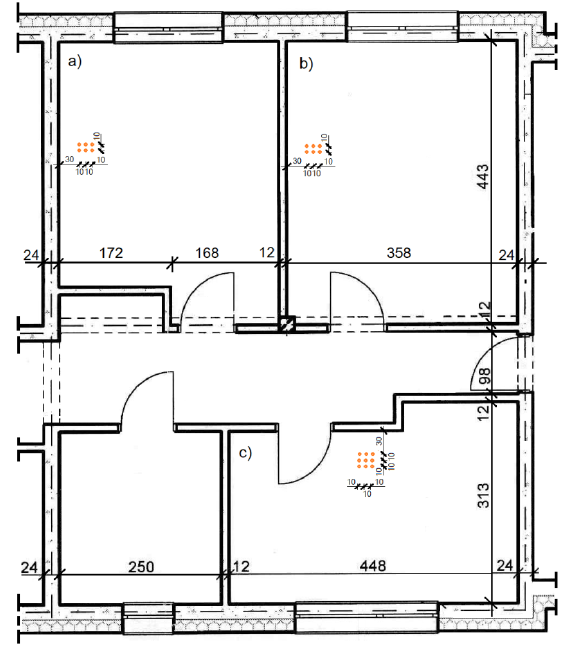
Figure 3: Sketch of the placement of measurement benchmarks (dimensions in centimetres): a) room R-PF, b) room R-G, c) room